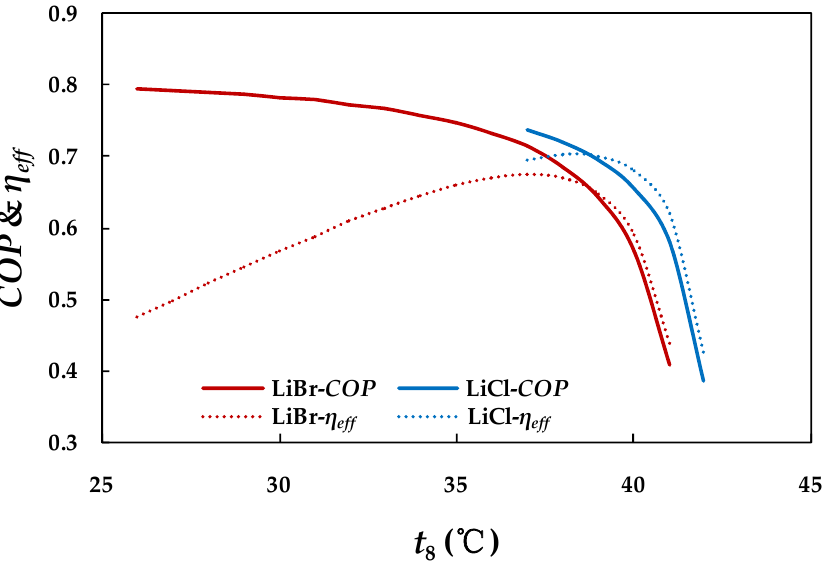
Figure 8. Condenser temperature impact on the COP and efficiency ratio of absorption system under the examined operating condition for the two working pairs ( t 1 = 40 °C, t 4 = 80 °C, t 10 = 7 °C, ε = 0.7).